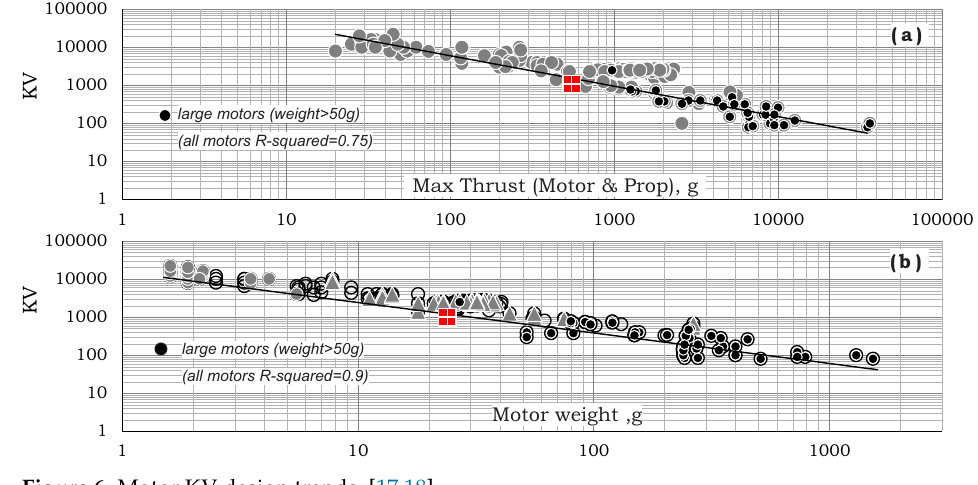
Figure 6. Motor KV design trends, [17,18].